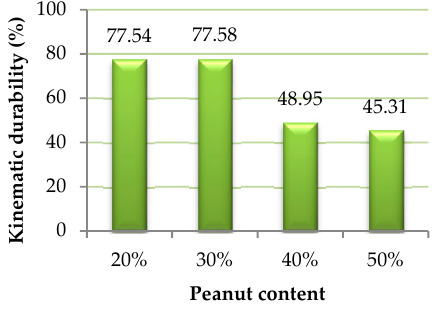
Figure 3. Dependence of the content of peanut in the mixture with sponge flour on the kinetic durability of the